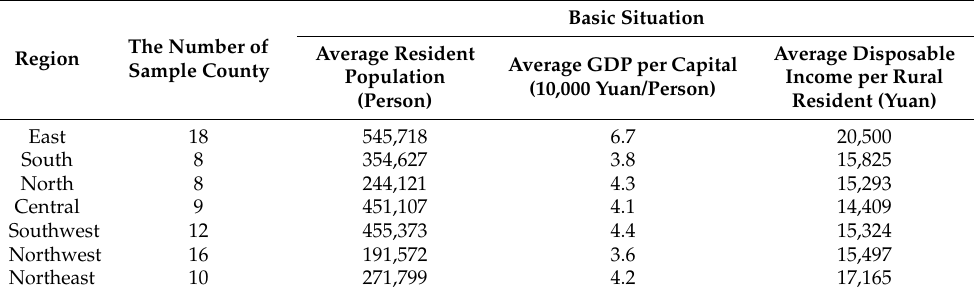
Table 1. Information and basic situation of sample counties in the seven regions.